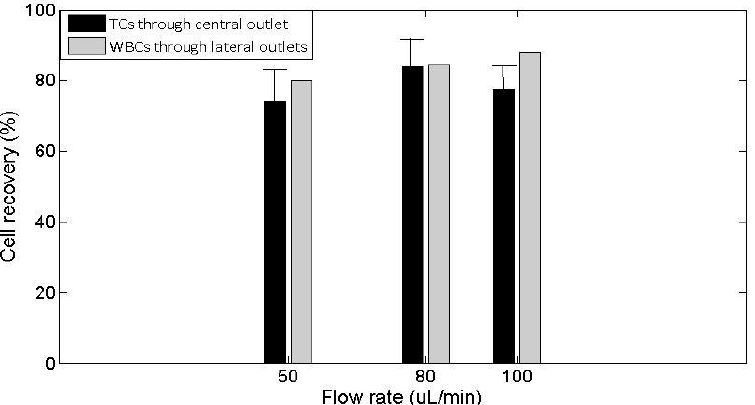
Figure 6. Results of the quantified capture efficiency of the cancer cell separation (%) of pancreas cancer cells (Panc-1) spiked in RBC-lysed blood samples obtained in the THINUS-Chip at f = 952 kHz and V p-p = 28 V. The values given are means, the error bars denoting min and max